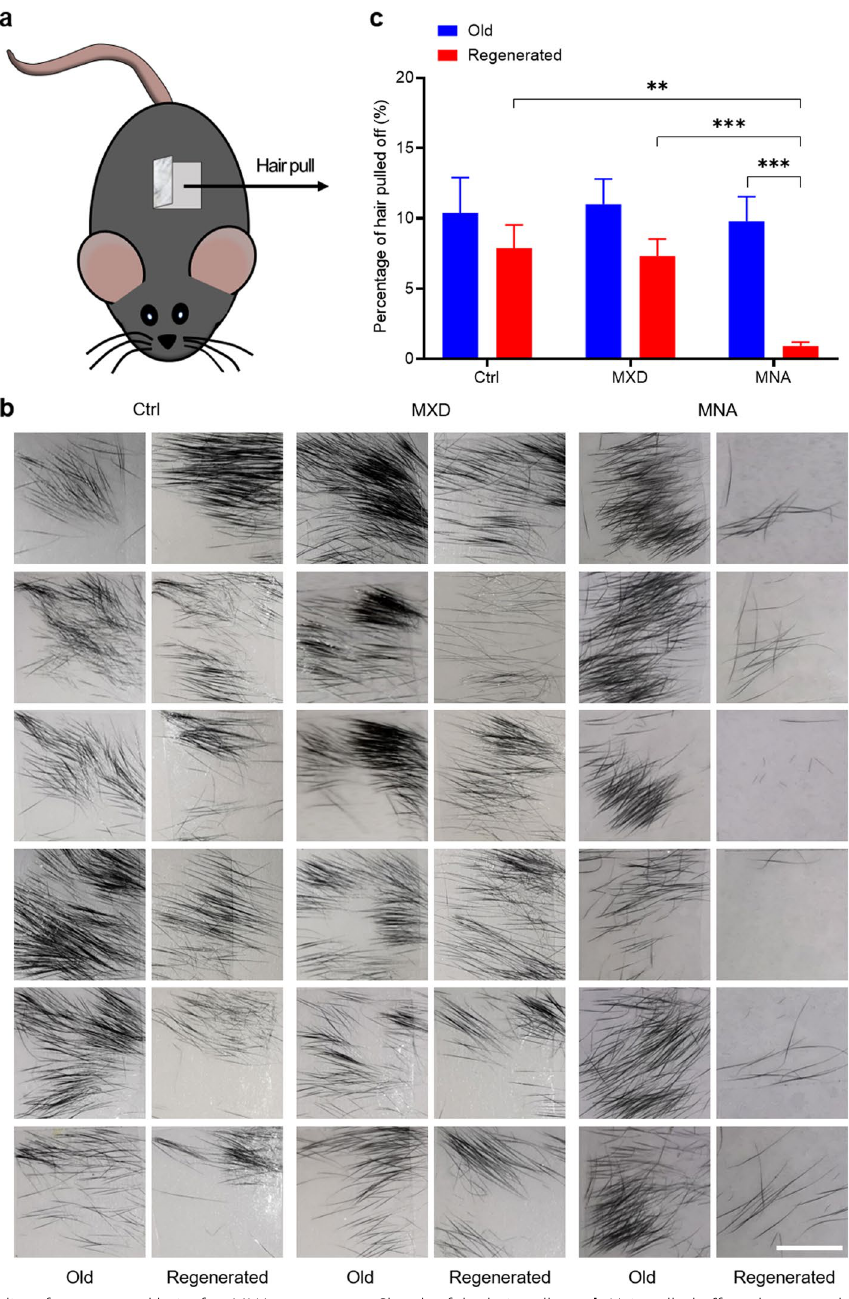
Fig. 4 Improved quality of regenerated hair after MNA treatment. a Sketch of the hair pull test. b Hair pulled off on the tapes showed that shed hair was reduced in MNA-induced regenerated hair. (Scale bar: 0.5 cm). c The percentage of hair pulled off was obtained by calculating the gray value of the photos. * P < 0.05, ** P < 0.01, *** P < 0.001, n =